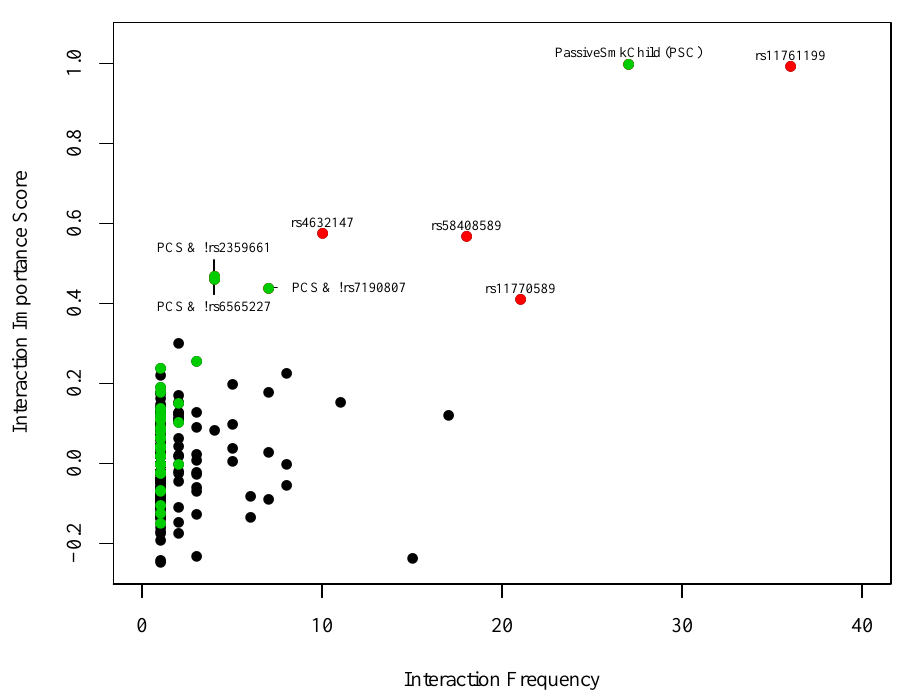
Figure 4. Interaction frequency by normalized interaction importance score for all interactions identified in the LF model. Points highlighted in red represent the interactions that have the largest combination of frequency and importance score. Points in green represent additional interaction terms identified in the forest that include passive smoke exposure as a child with at least one